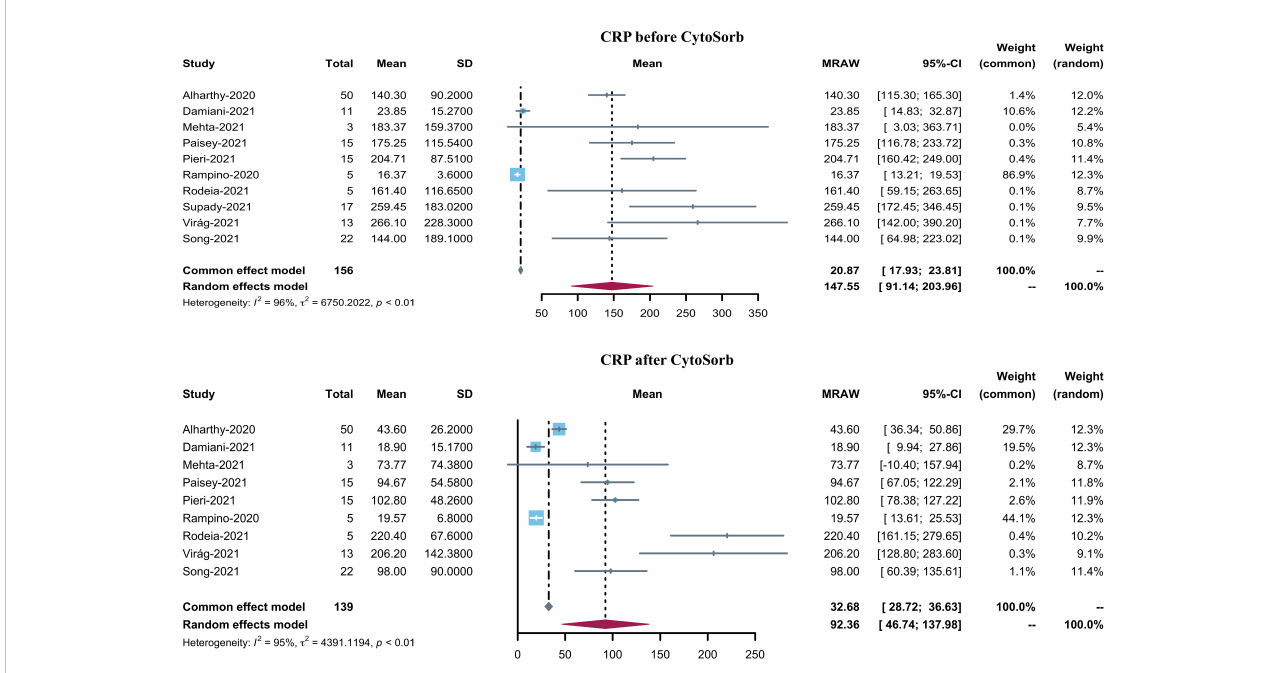
FIGURE 3 Forest plot of serum CRP before and after CytoSorb treatment for COVID-19 patients. CI: con fi dence interval; SD: standard deviation; CRP: C-reactive protein.